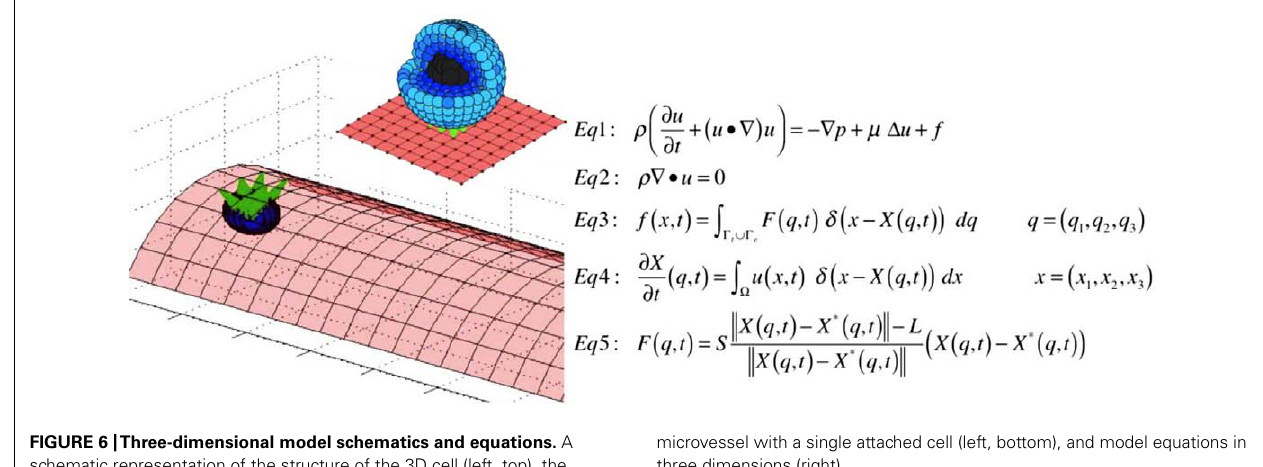
Frontiers in Oncology | Cancer MolecularTargets